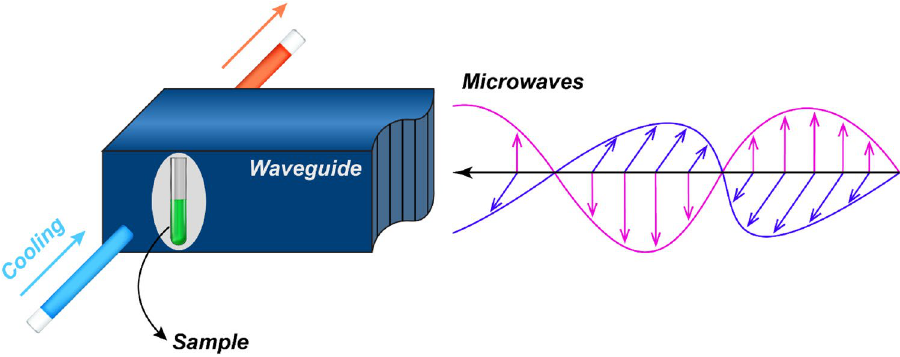
Figure 1. The sample is placed inside a microwave waveguide and connected to an efficient cooling system.